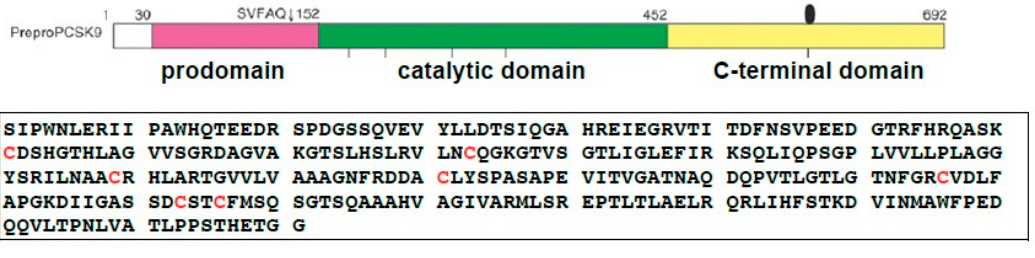
Figure 9. The amino acids sequences of mouse PCSK9 catalytic domain (residues 152-452). All Cysteins (C) are marked in red. (C) are marked in